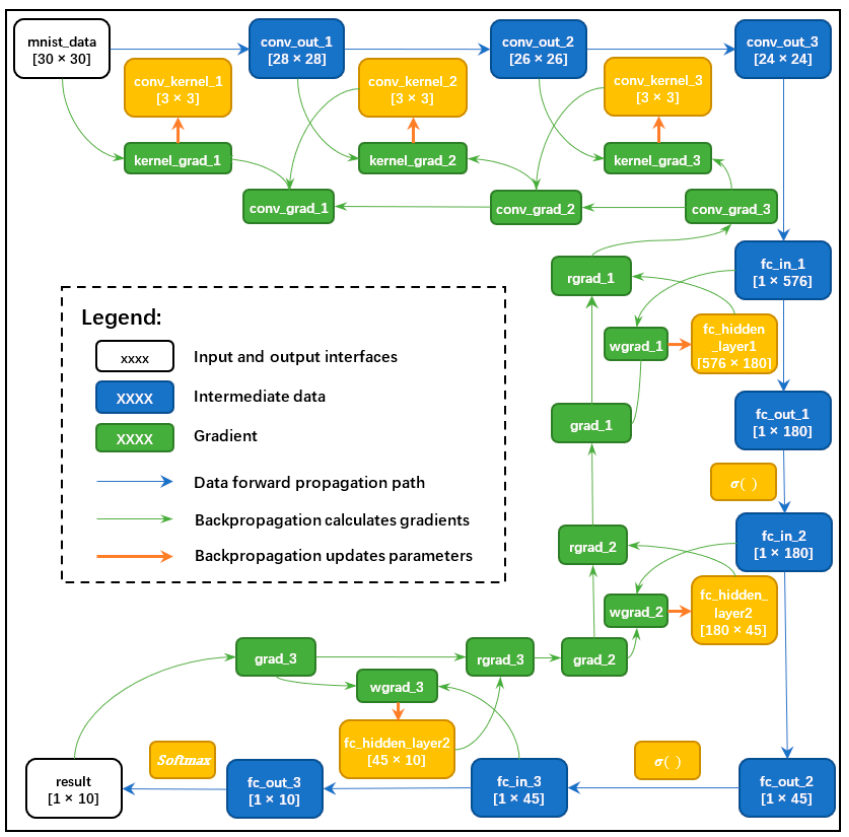
Figure 5. Data flow of network forward propagation and backpropagation.